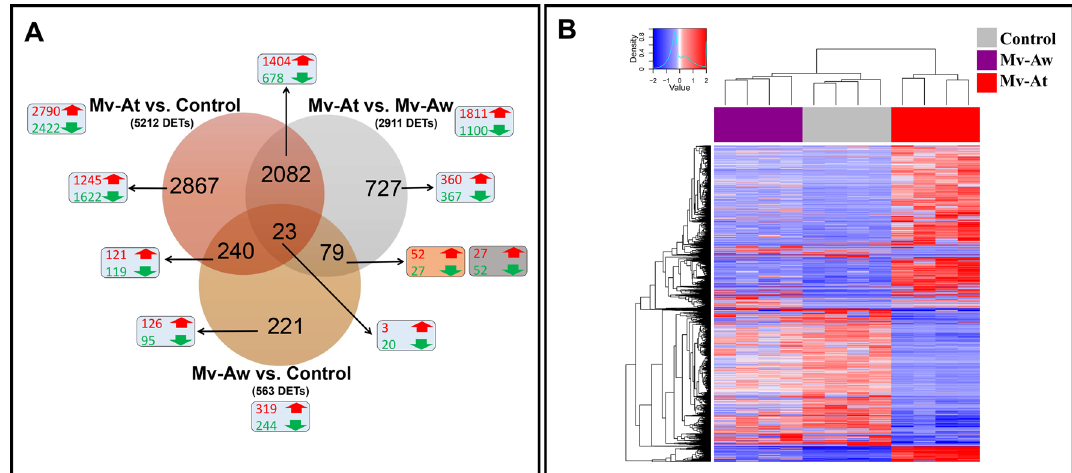
Figure 1. RNA-Seq results of Atlantic salmon skin response to M. viscosa infection. The skin samples of M. viscosa -infected Atlantic salmon at the lesion (Mv-At) and away (Mv-Aw) sites, as well as the skin samples of non-infected control group, were used for RNA-Seq ( n = 4). Differentially expressed transcripts (DETs) were identified by DESeq2 ( p adj < 0.01). ( A ) Overview of RNA-Seq results. The number of up-regulated (red) and down-regulated (green) transcripts in a given comparison is shown in the light turquoise boxes, whereas orange and grey boxes indicate DETs associated with Mv-At vs. Mv-Aw and Mv-Aw vs. Control, respectively. ( B ) Hierarchical clustering analyses of RNA-Seq results, using all DETs identified in the present